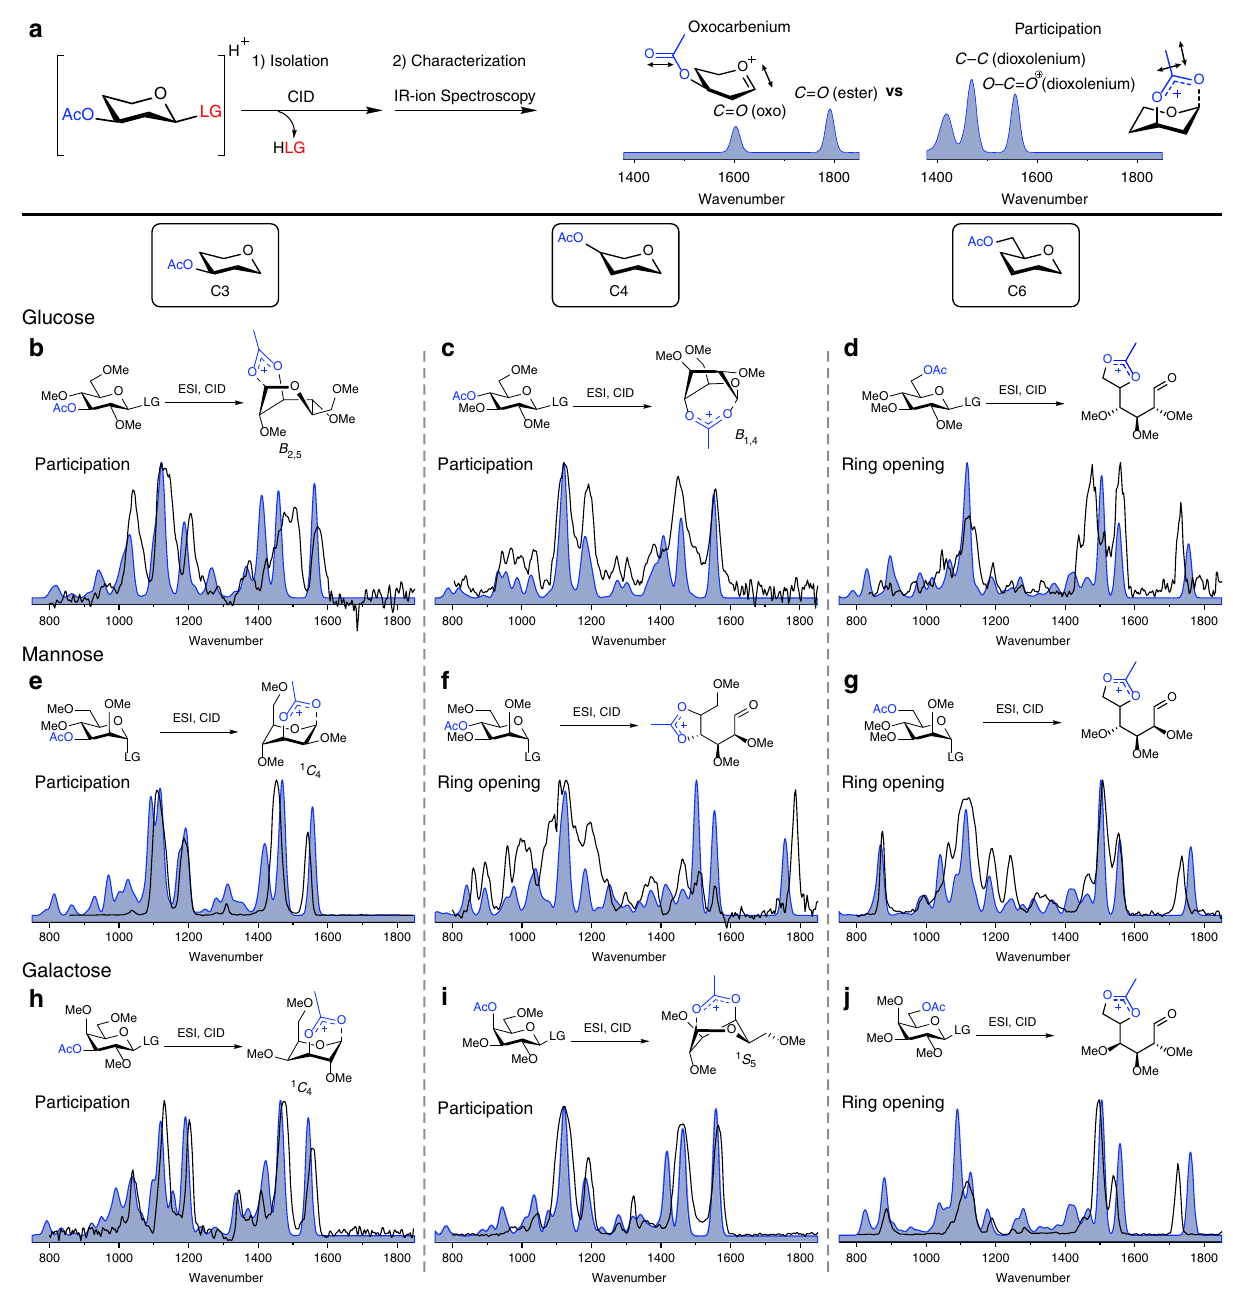
Fig. 3 Infrared ion spectroscopy of glycosyl cations. a Oxocarbenium ions and dioxolenium ions give different diagnostic peaks (in blue). Overview of a comparison of the computed IR-ion spectra ( fi lled blue) and the measured IR-ion spectra (black line) of the glycosyl cations derived from glucosyl ( b – d ), mannosyl ( e – g ) and galactosyl ( h – j ) donors 1 – 9 . Ring-opening of donors 3 , 5 , 6 , and 9 have been presented as accessible structures, their exact conformation is presented in Supplementary Figs. 3, 5, 6, and 9 and coordinates presented in the Supplementary Data fi which connect these on the CEL. We adopted this method here more information see Supplementary Methods). To probe the (Fig. 4) to evaluate the relative stability of the oxocarbenium and difference in glycosyl cation structure between the IRIS gas-phase dioxolenium ions derived from 1 to 9 (Fig. 5). Two rotamers of experiments devoid of solvent and glycosylation experiments the acetyl ester were taken into account and separately visualized performed in solution (vide infra), CEL maps were generated for as a CEL map: rotamer 1 (R1) in which the acetyl is pointing ions formed in the gas-phase at room temperature and in solvent toward C-1 making LRP geometrically feasible, and rotamer 2 (computationally evaluated using a polarizable continuum model, (R2) in which the acetyl points away from C-1 making the see SI) at − 60 o C at which the experimental glycosylations take place, respectively. Figure 5a – i depicts the maps for the solution- inspection of the oxocarbenium ion possible. The geometry of all phase ions, while Fig. 5j summarizes the relative energy of the the conformers was optimized by DFT using the hybrid func- structures found in the solution-phase and the gas-phase (all gas- tional B3LYP and the basis set 6 – 311 G(d,p), which presents an phase CEL maps can be found in Supplementary Fig. 25). practical trade-off between computing time and accuracy (for